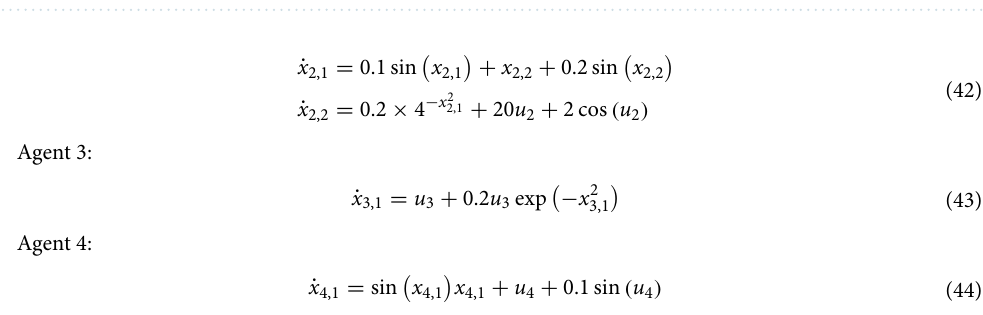
Figure 3. Topology of the multiagent